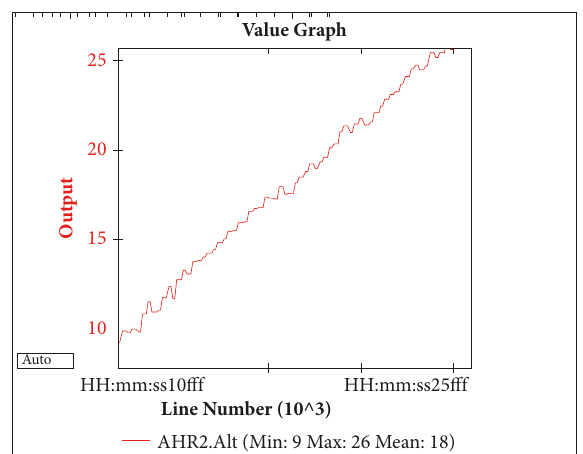
Figure 16: The flight height of the DTR aircraft.